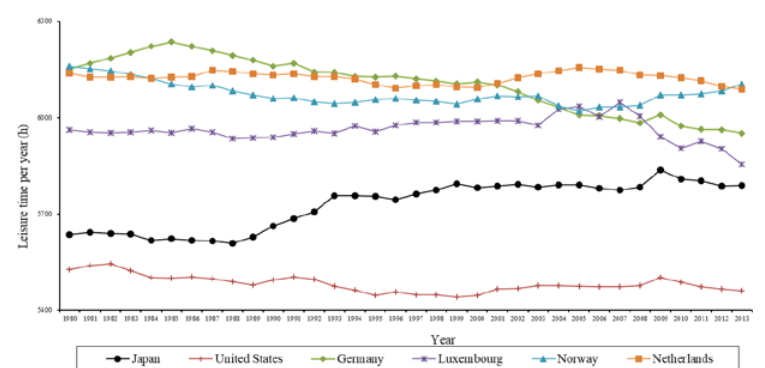
Figure 4: Comparison of leisure time in six